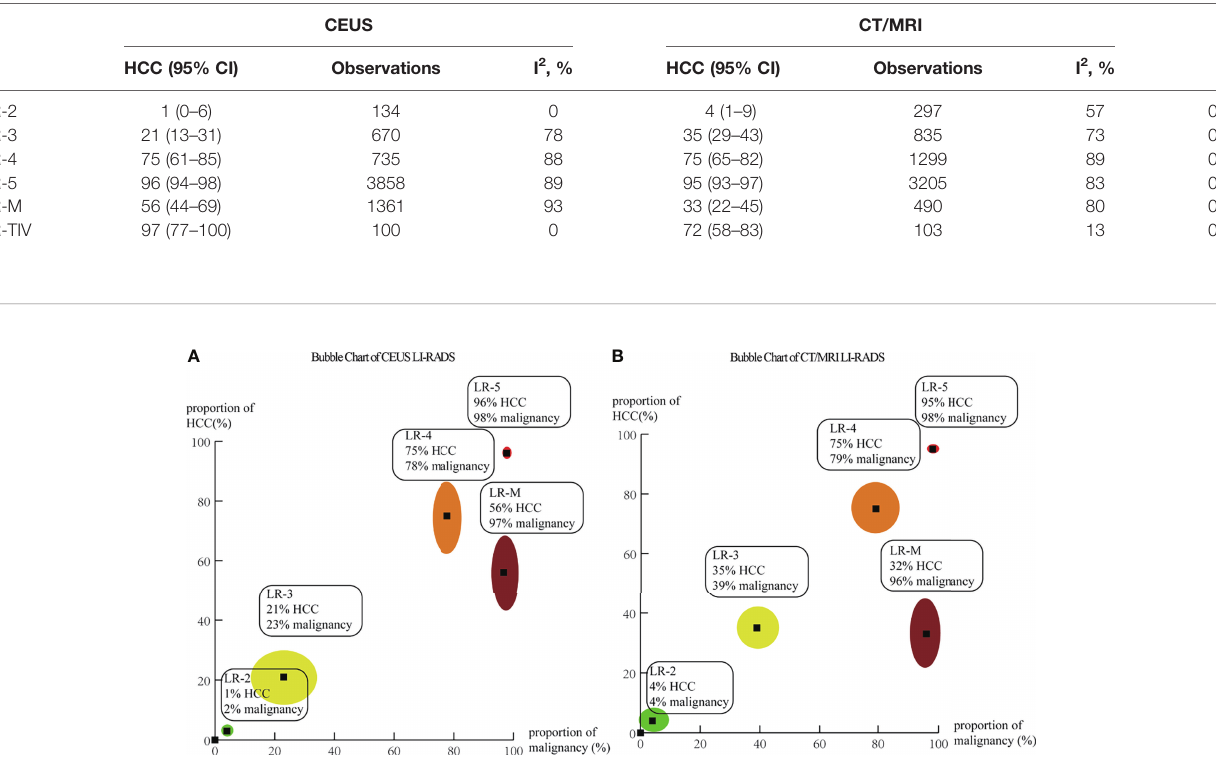
FIGURE 2 | Bubble chart based on pooled percentage of HCCs and non-HCC malignancies for each category of CEUS (A) and CT/MRI (B) LI-RADS. The points at the centers of bubbles correspond to the pooled percentages of HCCs and non-HCC malignancies. The outer bubble margins correspond to 95% CIs for percentages of HCCs (y-axis) and non-HCC malignancies (x-axis).